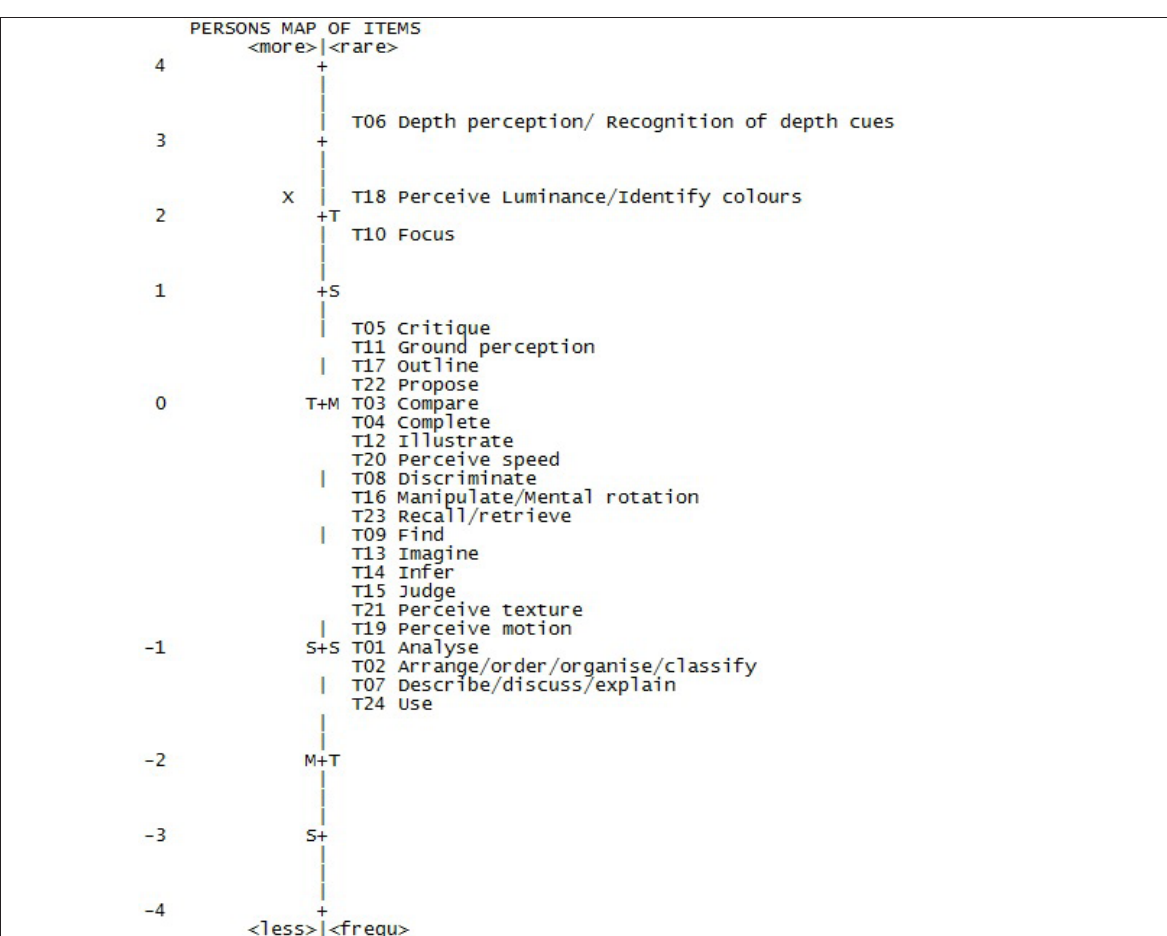
Figure 2: Item difficulty map for Campus A students ( n =31).